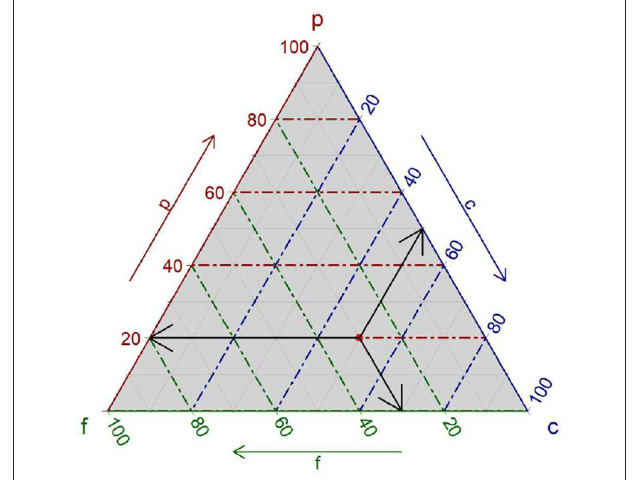
FIGURE 1 | An example of ternary plots. A red point shows a compositional datum of P:F:C 20:30:50. Three sub-compositions can be read at three = axes showing by the cross-hair.